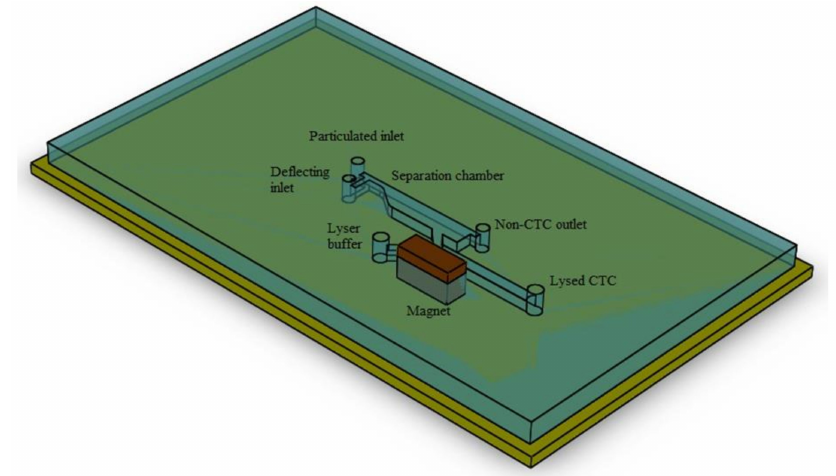
Figure 1. 3D schematic of the designed biochip composed of separator and mixer subunits; as can be observed, two units are arranged in serial configuration. In the first chamber, the CTCs are separated from the background cell by implementation of magnetic force and in the mixer unit by utilization of alternating voltage the mixing is achieved.